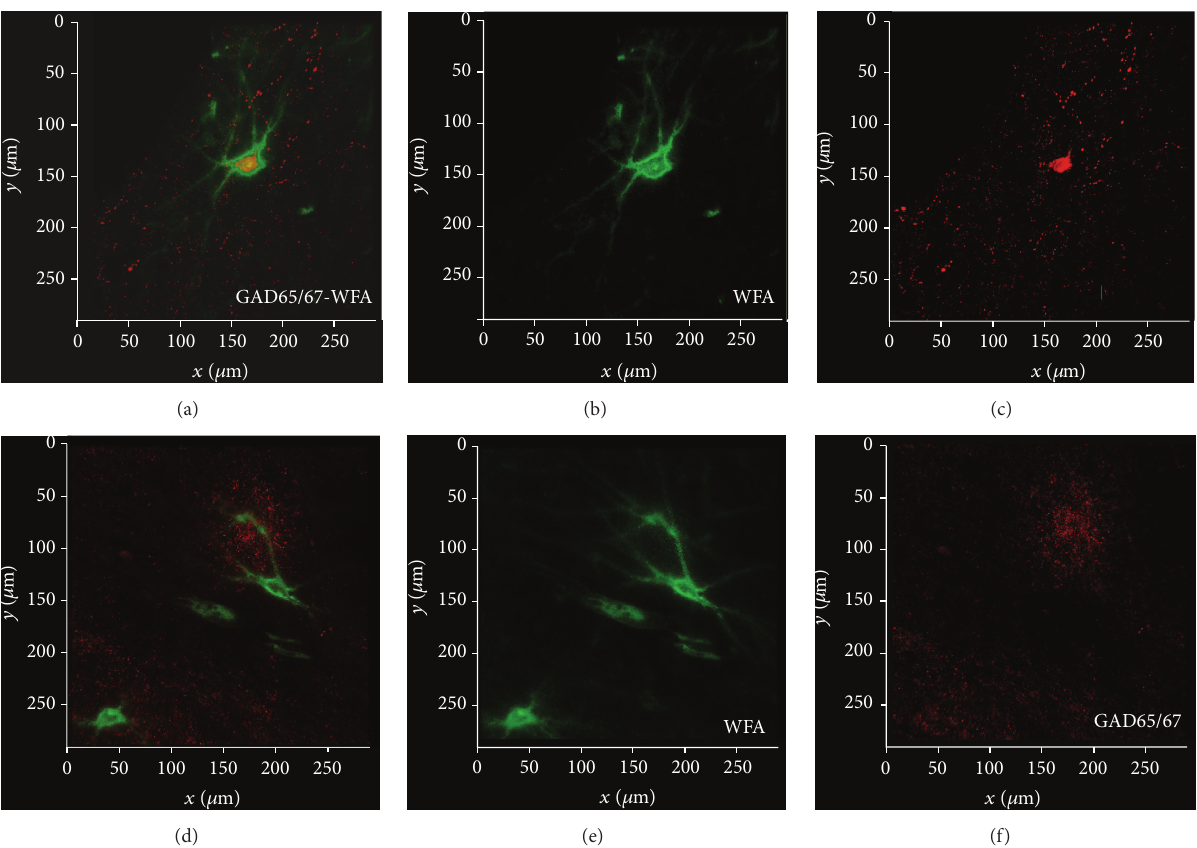
Figure 3: PNNs are associated with heterogeneous neuronal populations. Confocal micrographs depicting WFA-labeled PNNs surrounding GABAergic neurons expressing GAD65/67 in the healthy human amygdala (a–c). Consistently, WFA-labeled PNNs have been shown to be typically associated with neurons expressing parvalbumin. However, we have previously reported that a small subpopulation of these PNNs ensheathes parvalbumin-negative neurons [152]. Preliminary findings shown in (d)–(f) suggest that these neurons do not express GAD65/67 and may therefore correspond to excitatory